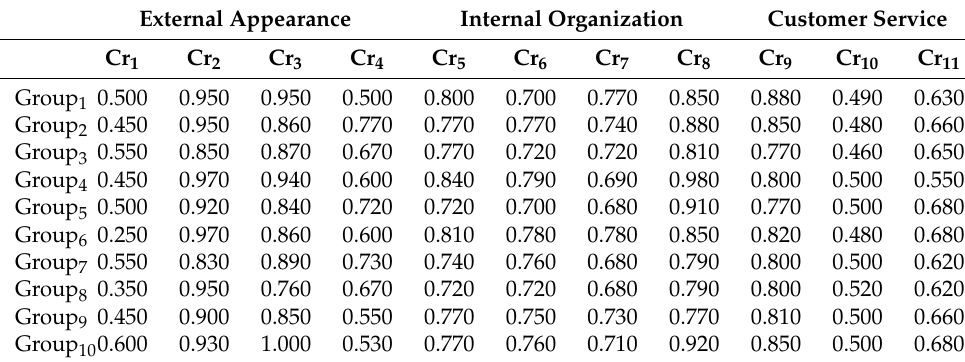
Table 7. Valuations of consumers.